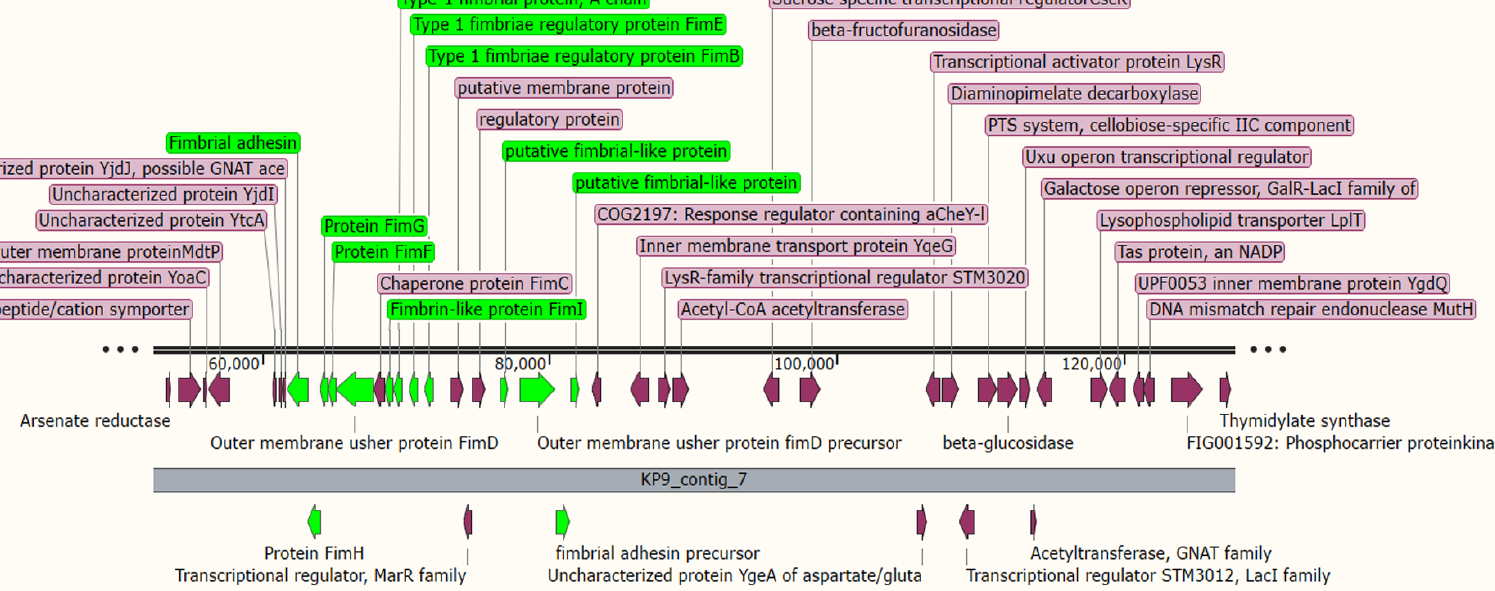
Figure 2. Clustering of fimbrial proteins in contig 7 of K. pneumoniae 9KP; the horizontal black lines indicate the contig length, the green arrows indicate genes encoding fimbrial proteins, and the purple arrows indicate other genes located at the same contig.